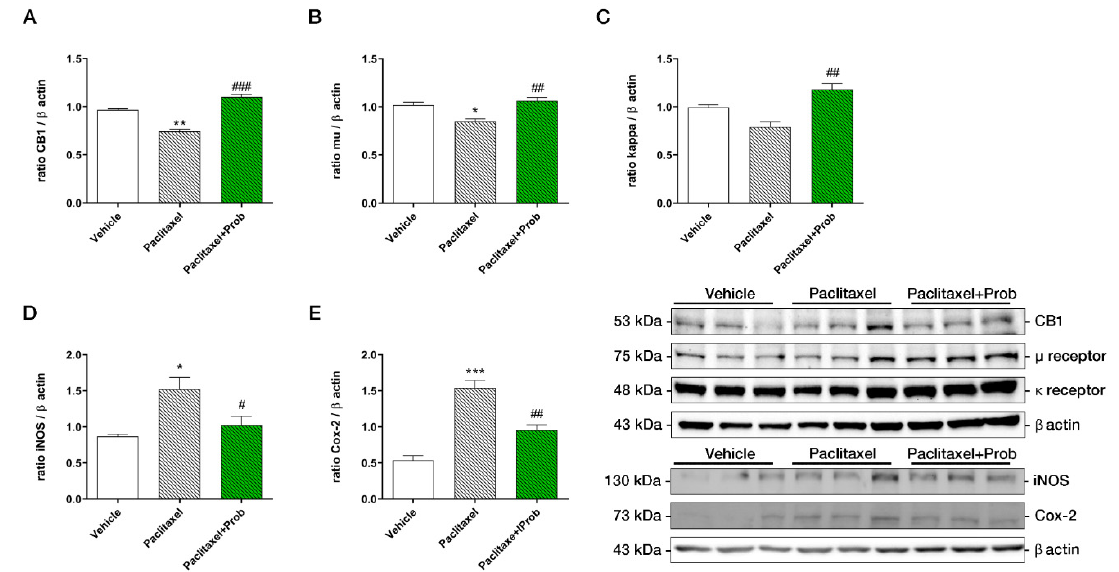
Figure 4. Western blotting analyses for CB1 ( A ), µ ( B ) and kappa ( C ) receptors, iNOS ( D ), and Cox-2 ( E ) proteins in spinal cords. ***, p < 0.0001; **, p < 0.005; #, *, p < 0.05 vs. vehicle; ###, p < 0.0001, ##, p < 0.005; #, p < 0.05 vs. paclitaxel ( n = 3). A representative figure for each protein is shown.